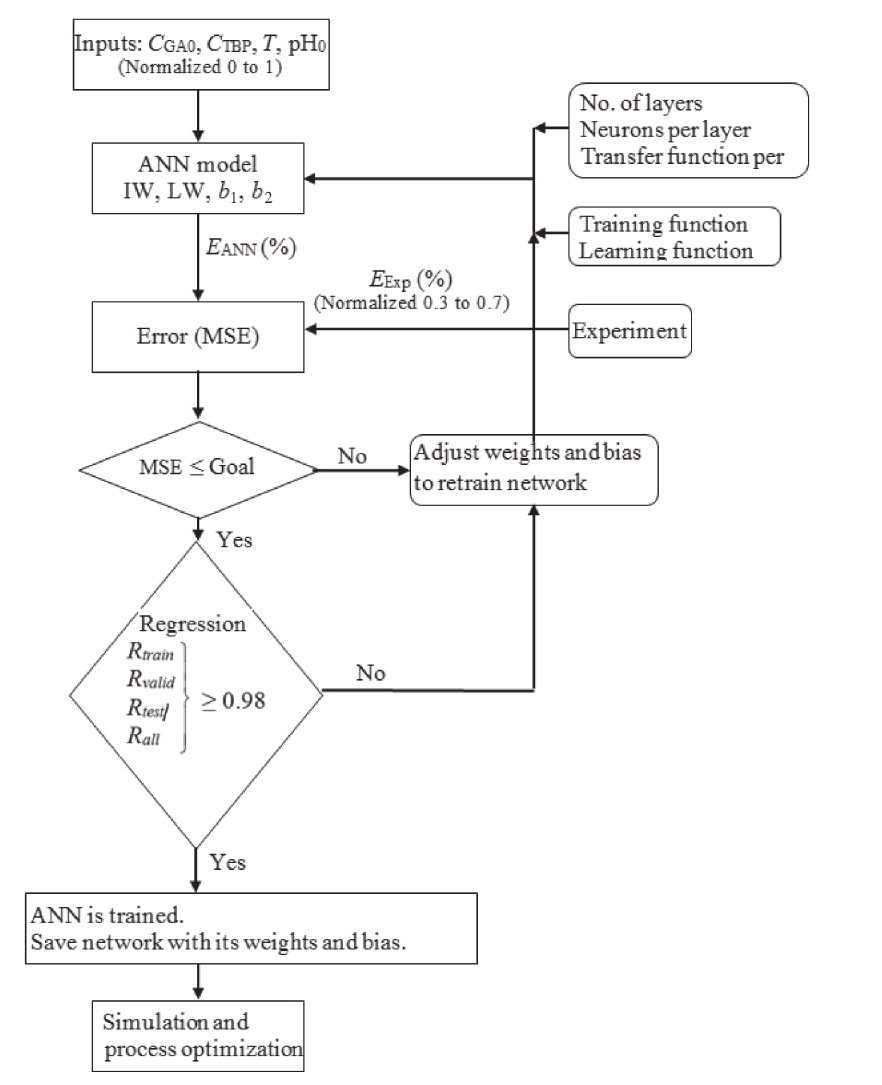
Fig. 5 – Feed forward backpropagation algorithm used in the ANN training for the prediction of GA extraction efficiency